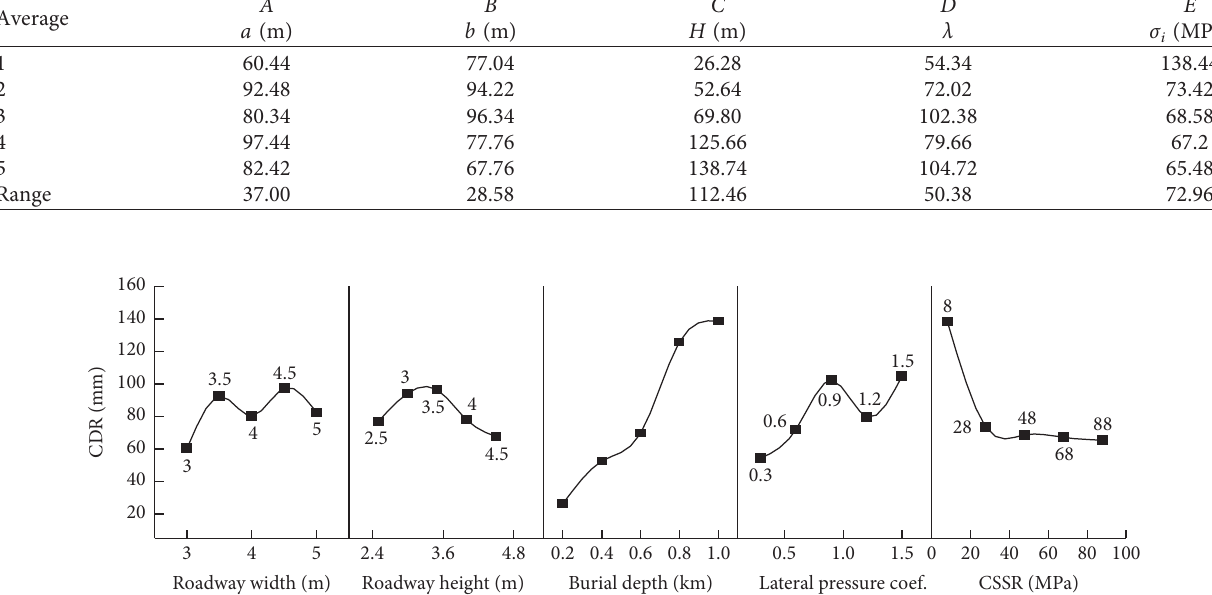
Figure 8: The effect of each factor on the roadway stability.